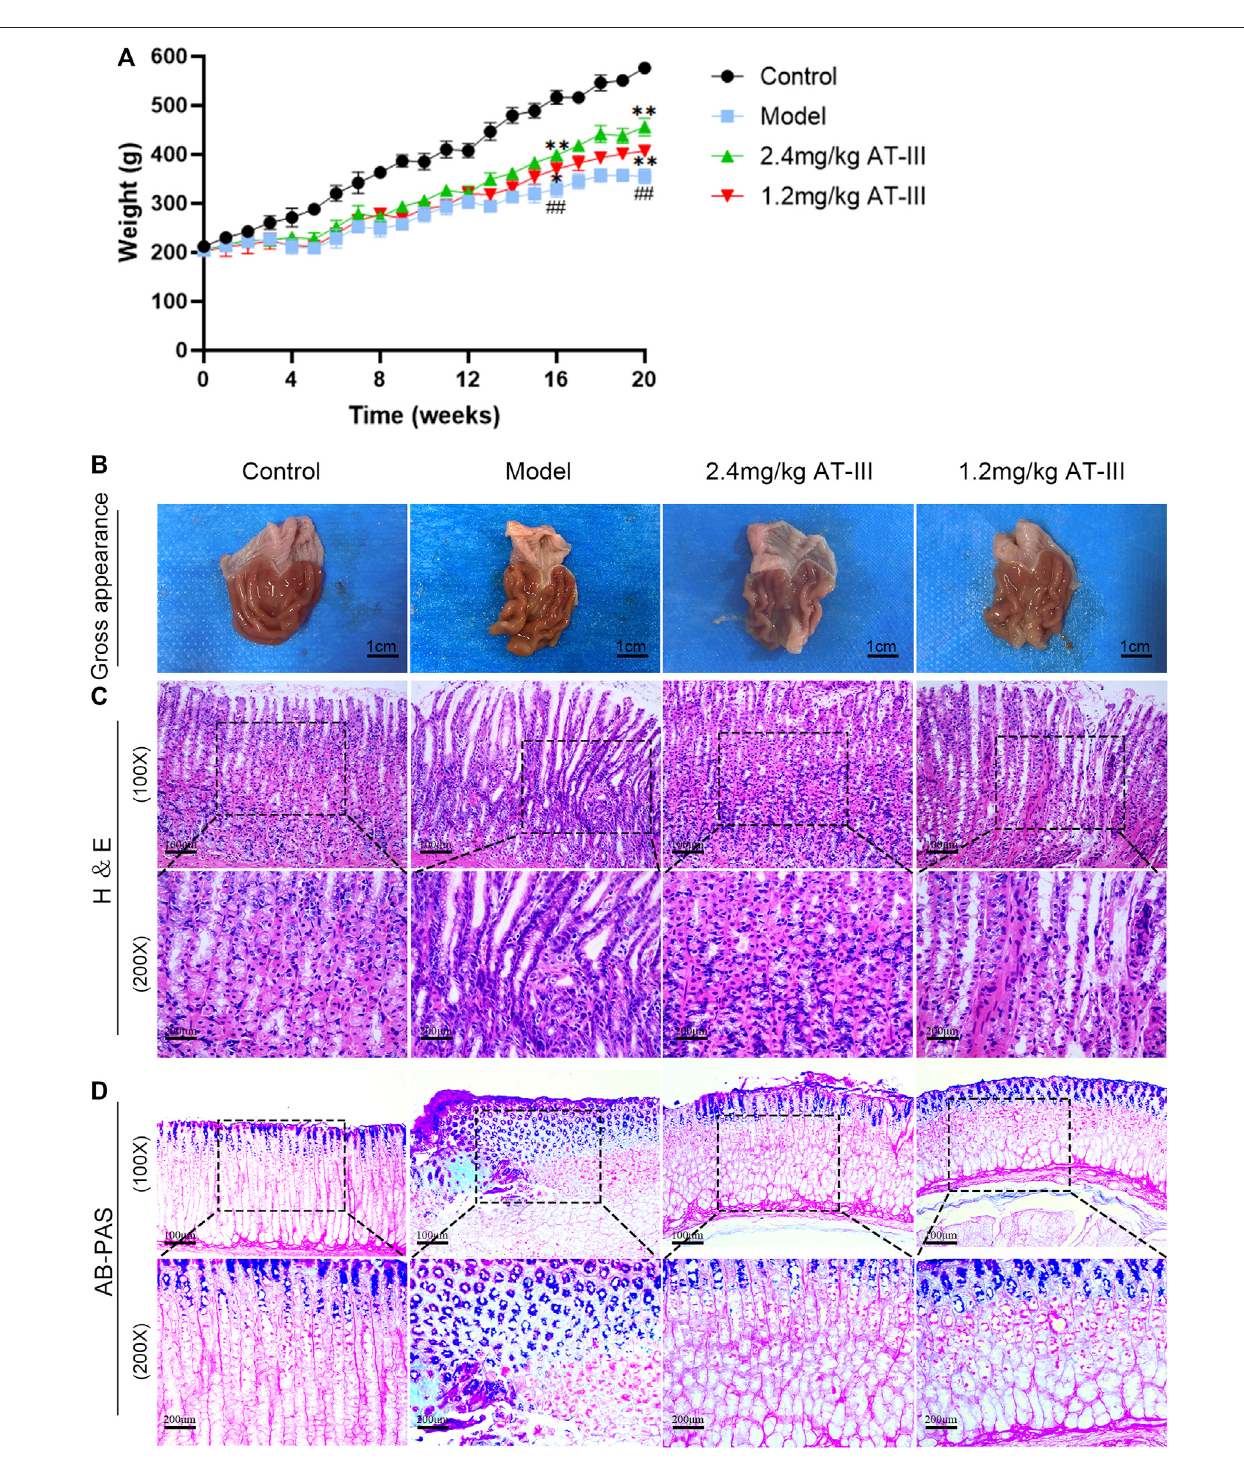
FIGURE 2 | Effects of AT-III on pathomorphology of dysplasia, gastric intestinal metaplasia and body weight in GPL rats. (A) Effect of AT-III treatment on body weight of GPL rats. (B) Gross evaluation of the gastric mucosa. (C) Representative images of H & E staining of the gastric epithelium (×100, ×200). (D) Evaluation for intestinal metaplasia using AB-PAS staining (×100, ×200). ## p < 0.01 versus the control group; * p < 0.05, ** p < 0.01 versus the model group. Abbreviations: AT-III, Atractylenolide III; GPL, gastric precancerous lesions; H & E, hematoxylin and eosin; AB-PAS, alcian blue-periodic acid schiff.